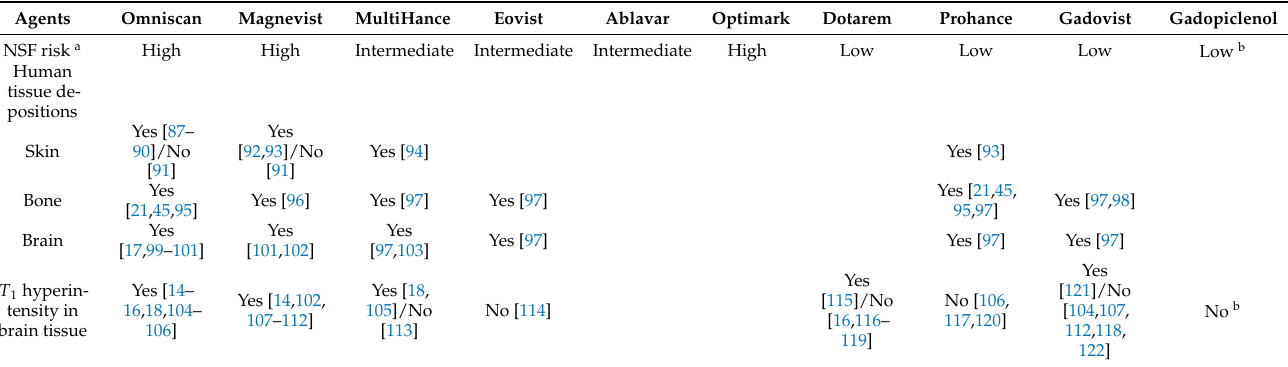
Table 2. Overview of gadolinium depositions from GBCAs in